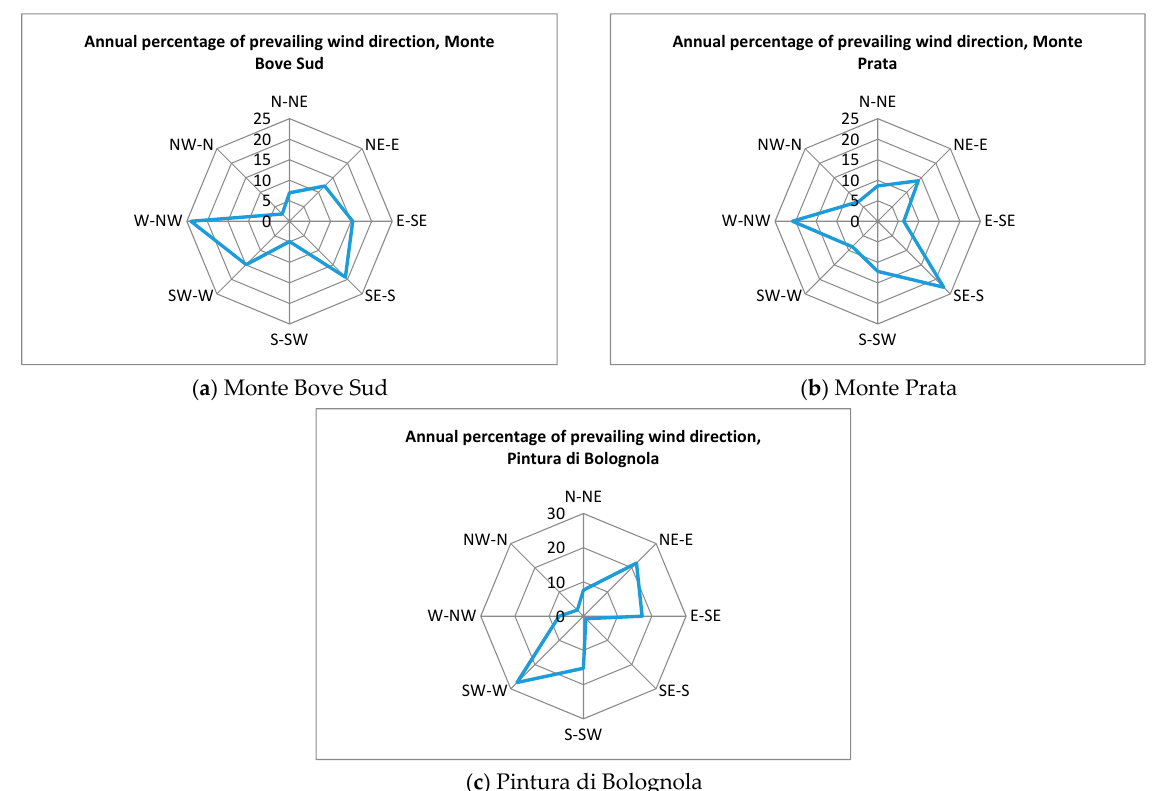
Figure 4. Annual percentage of prevailing wind direction from 2010 to 2020. Obviously, each case of each weather station has to be evaluated separately, but in the case of MB and PB, with the weather stations downwind for certain wind directions (Figure 5), it leads to an underestimation of the precipitation measured by the rain gauge compared to the IMERG data of about 30–50%. Obviously, although with the IMERG data there is less underestimation of the data from the high-altitude rain gauges, they cannot be considered completely reliable, as they probably also underestimate the real value of precipitation, as can be seen from the difference between the precipitation data of the PB rain gauge (at a lower altitude than the other two weather stations) and the satellite data.